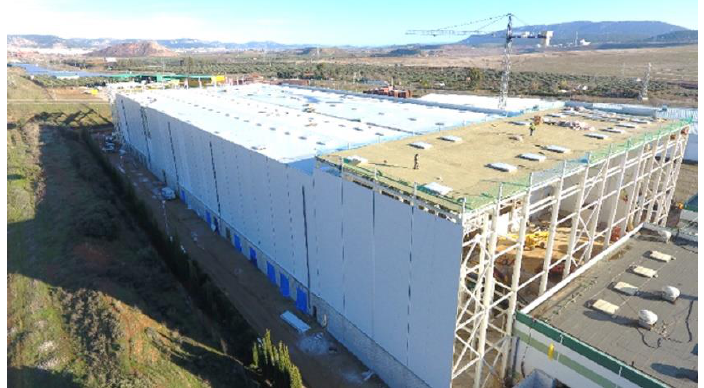
Figure 3. UMG-Si production factory at Puertollano (Spain).